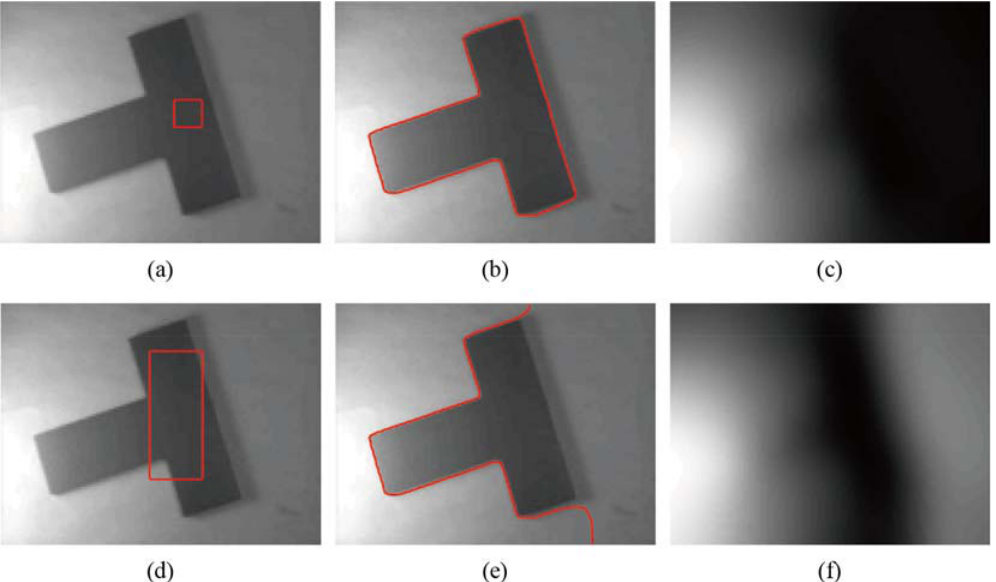
Fig 2. Segmentation of Li ’ s model. (a), (d) The original image with red initial contours. (b), (e) Segmentation results of Li ’ s model. (c), (f) The bias field estimation of Li ’ s